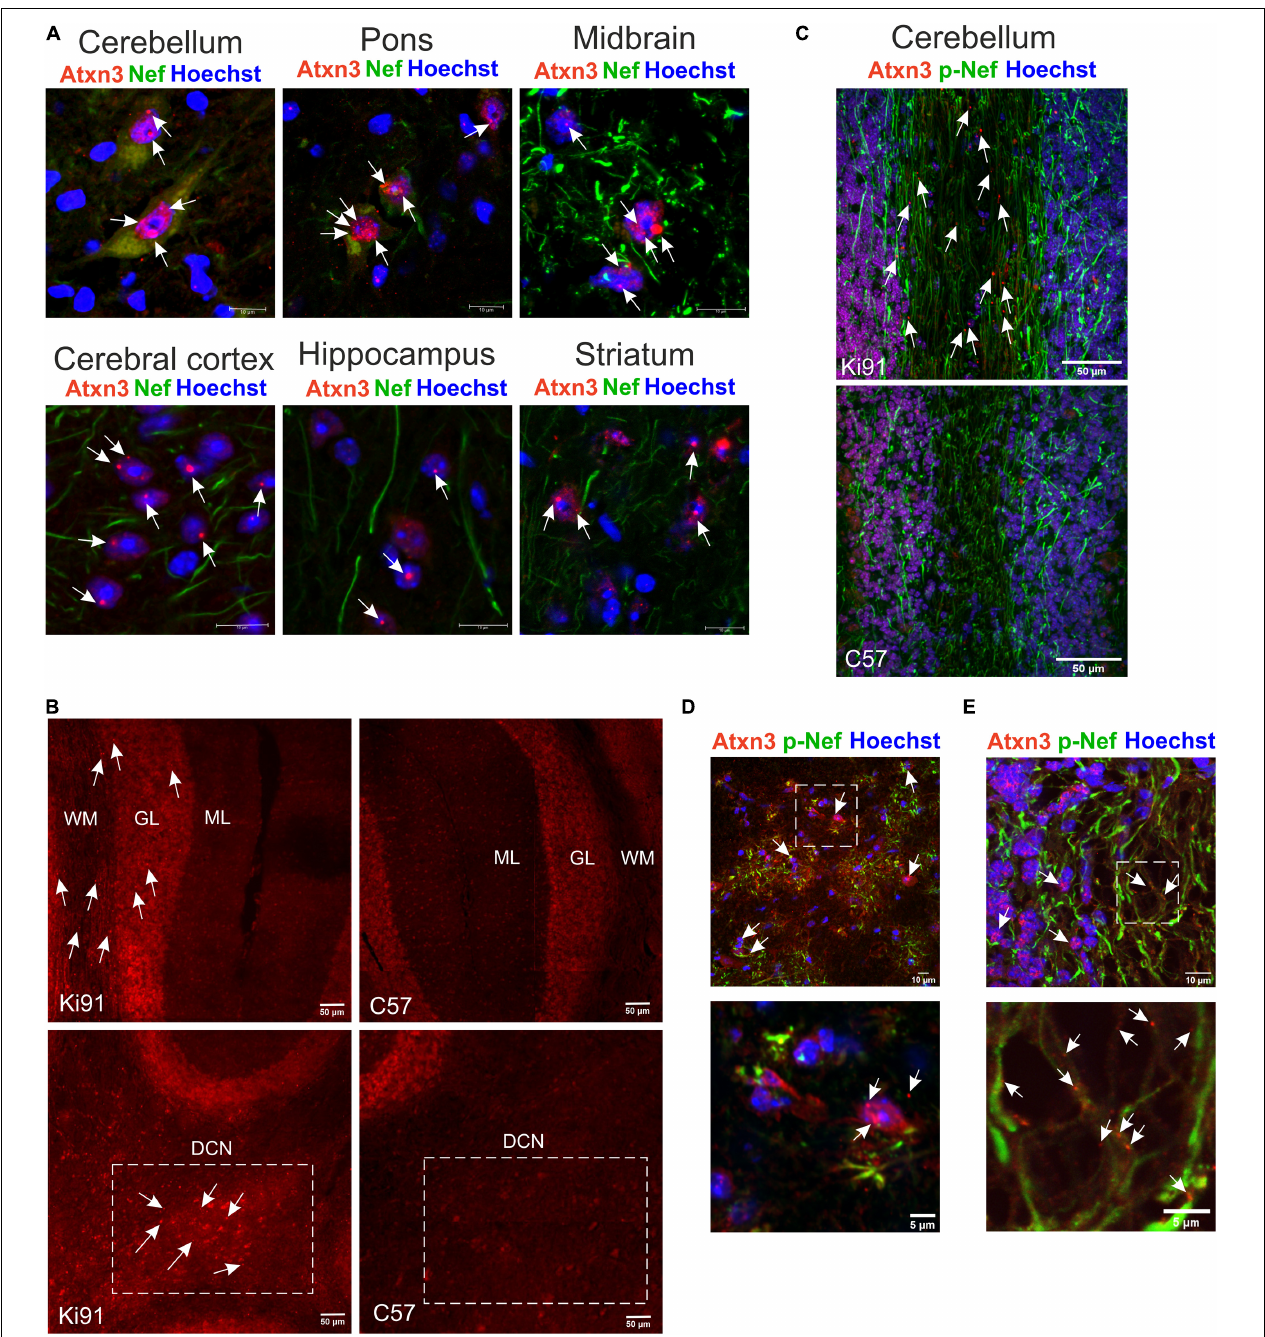
FIGURE 3 | The presence of multi-region intra-nuclear and intra-axonal inclusions in Ki91 SCA3/MJD brain. The ataxin-3 immunostaining of the 18-month-old Ki91 brain sections revealed a large number of cells within the cerebellum, midbrain, pons, cerebral cortex, hippocampus, and striatum with ataxin-3 (red; rabbit anti-ataxin-3 antibody) localizing mainly in the cell nucleus (blue; Hoechst 33342) (A) . White arrows indicate large intra-nuclear inclusions; however, many smaller inclusions throughout the brain were present. A rich representation of Atxn3 aggregates (red; rabbit anti-ataxin-3 antibody) was present in DCN, granular layer (gl), and white matter (wm) of the Ki91 cerebellum (B–D) . A significant number of small and large ataxin-3 inclusions were detected in the neurites (green; Smi-32, pan-neuronal or Smi-312, axon-specific antibody) of the Ki91 cerebellum (C,E) . White box and arrows in (D) mark prominent Atxn3 aggregates in the DCN area (lower panel represents the magnification of selected region in the upper panel). White box and arrows in (E) mark the magnified area containing multiple intra-axonal inclusions of Atxn3 (lower panel). Scale bars: 50 µ m (B,C) ; 10 µ m (A) ; 5 µ m on inserts (D,E) . N = 4 biological replicates; at least 4 pictures per brain region of each kind were